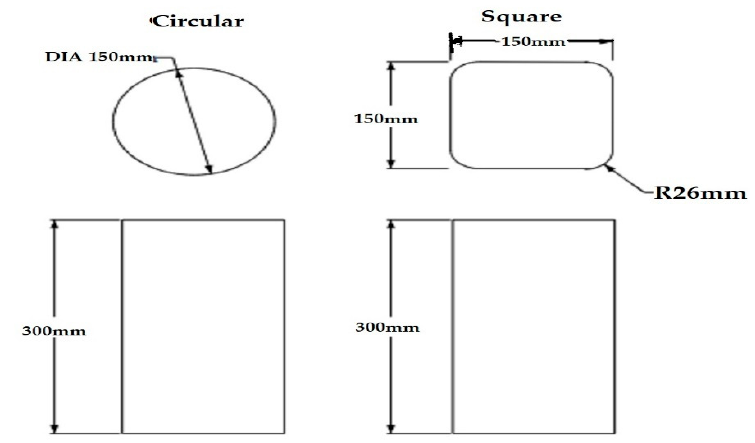
Figure 1. Dimensions of circular and square specimens.